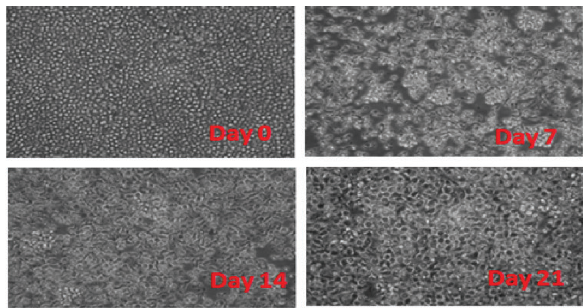
Figure 2: Flow cytometry was used to detect the surface antigen of CIK. CIK can be characterized by a panel of surface markers, which is positive for markers CD3 and